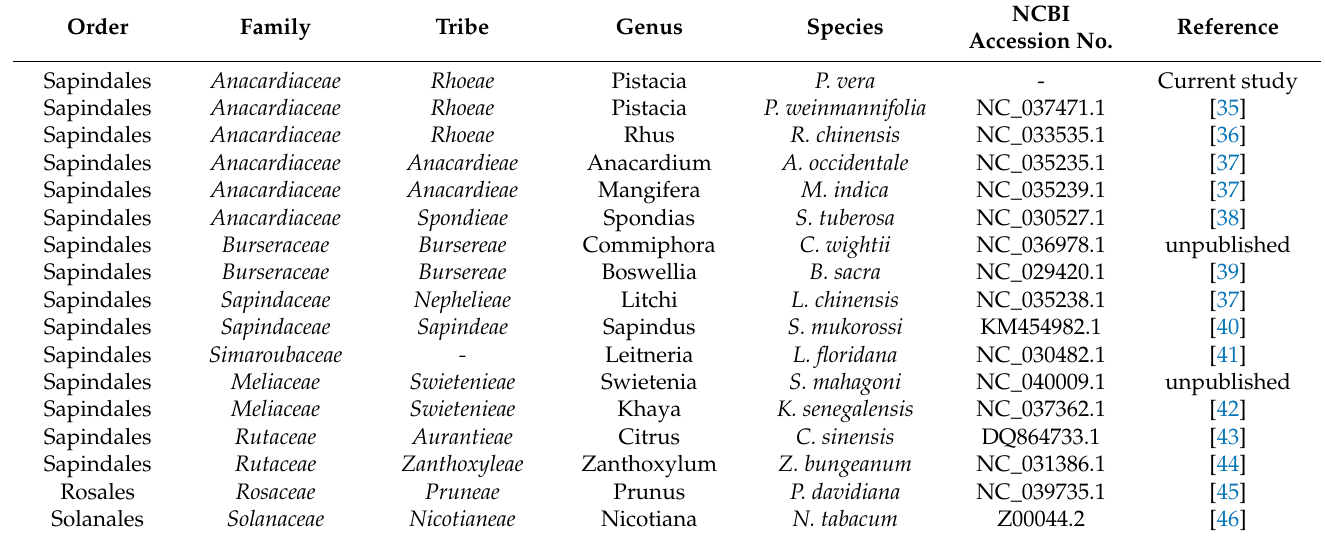
Table 1. List of plant species with published chloroplast genomes used for phylogenetic cluster analysis.